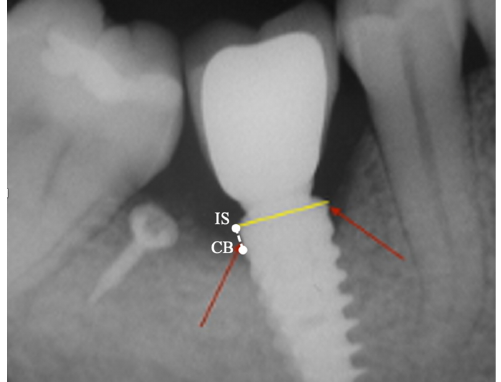
Figure 5. The implant is prosthesized 4 months after its insertion and bone levels around the implant are measured from the implant shoulder (yellow line) to the most coronal contact point of the mesial and distal marginal ridge (points are indicated by arrows in red). Legend: IS: implant shoulder; CB: crestal bone.